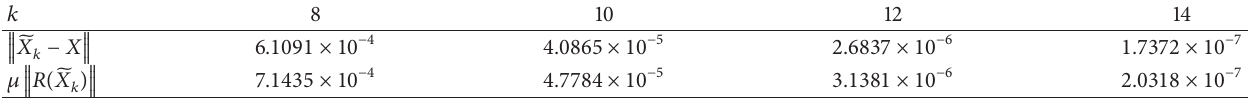
Table 3: Backward error bound for Example 16 with different values of 𝑘 .